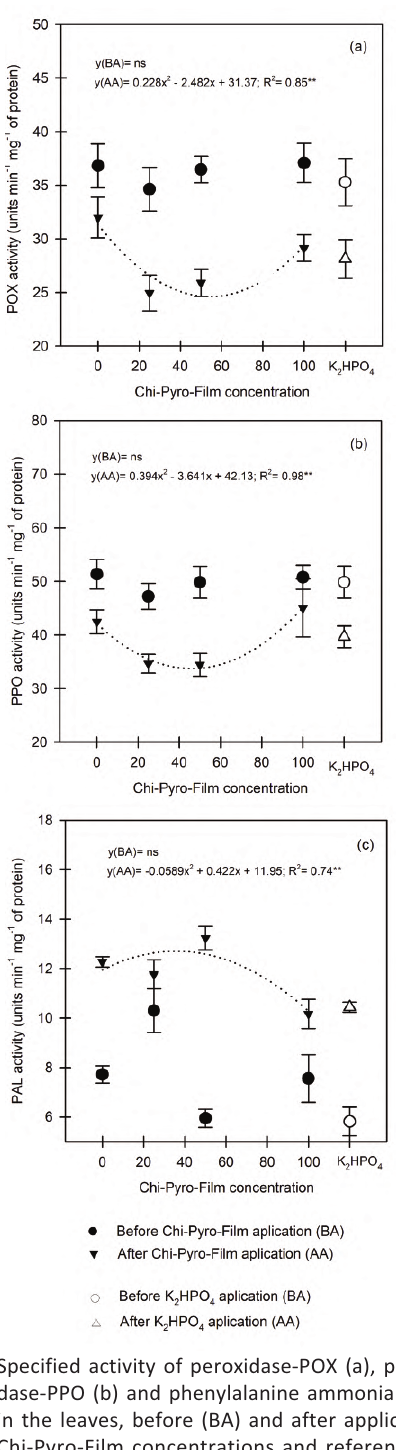
Fig. 6 ­ Specified activity of peroxidase­POX (a), polyphenoloxi­ dase­PPO (b) and phenylalanine ammonia lyase­PAL (c) in the leaves, before (BA) and after application (AA) of Chi­Pyro­Film concentrations and reference treatment HPO , 50 mM). Interaction effect between film con­ (K 2 4 centration and sampling time (before and 48 hours after application). *, **, ***, significant at p<0,05, p<0,01, p<0,001, respectively.